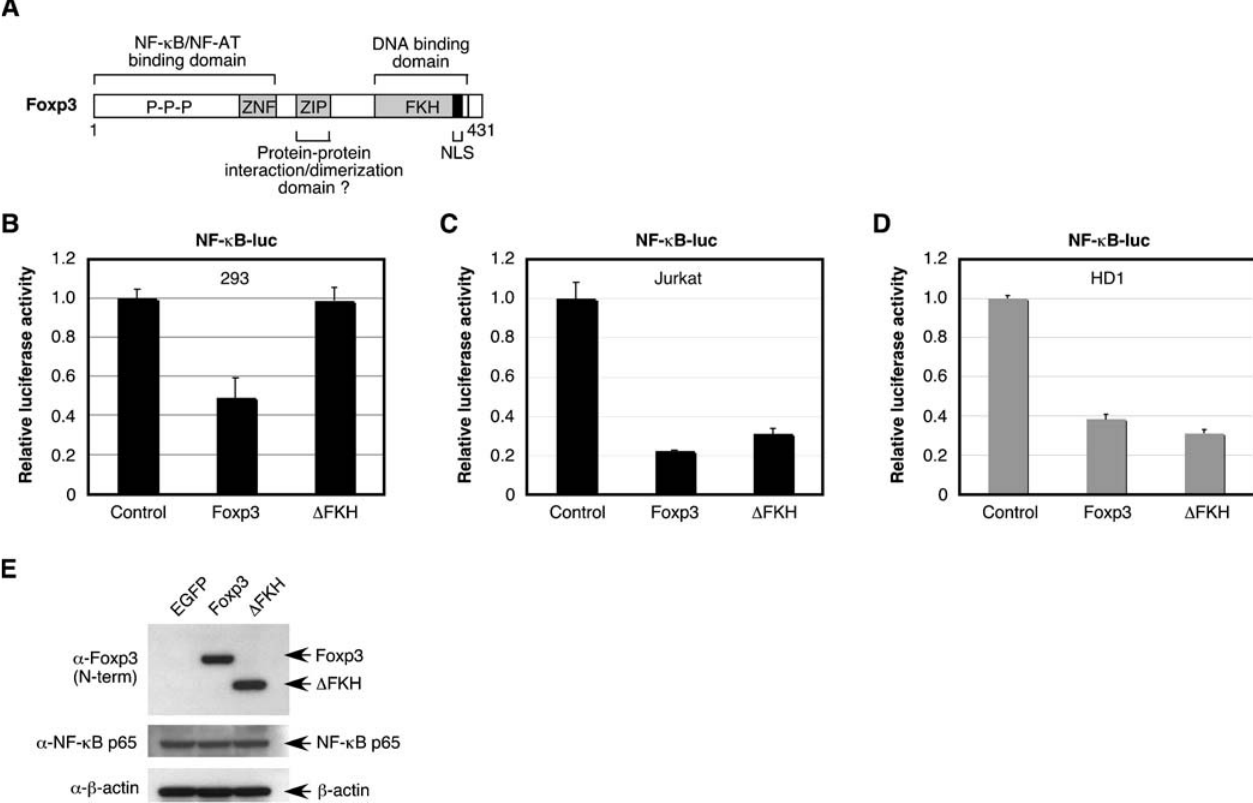
Figure 2. FKH Domain of Foxp3 Is Required to Inhibit NF- j B Activation in HEK 293T Cells but Not CD4 þ T Cells (A) Schematic representation of human Foxp3, including proline-rich (P-P-P), zinc finger (ZNF), leucine zipper (ZIP), and forkhead (FKH) domains. Mutations within the Foxp3 gene associated with IPEX have been previously described [4,14,43]. The FKH domain contains a nuclear localization signal (NLS), which is required for Foxp3 expression in the nucleus. (B and C) HEK 293T cells (5 3 10 5 ) (B) were seeded into six-well plates 1 d prior to transfection or Jurkat T cells (1 3 10 6 ) (C) were seeded into six-well plates on the day of transfection with an NF- j B luciferase reporter vector (200 ng) in the presence or absence of a Foxp3, D FKH, or control expression vector (1,000 ng) and internal reference plasmid (pGL4-TKhRluc2; 50 ng). Cells were harvested at 24 h posttransfection and analyzed for luciferase activity. Relative luciferase activity was normalized to the internal reference control. (D) CD4 þ T cells (2 3 10 6 ) from healthy donors were nucleofected with an NF- j B reporter plasmid (2,000 ng), together with either a Foxp3, D FKH, or control expression vector (2,000 ng), and an internal reference plasmid (1,000 ng). Cells were harvested 24 h posttransfection and analyzed for luciferase activity. Relative luciferase activity was normalized to the internal reference control. Results from one healthy donor are shown. (E) Foxp3, D FKH, and NF- j B p65 expression in whole-cell extracts (20 l g) derived from HEK 293T cells transfected with a control expression vector (EGFP), Foxp3, or D FKH expression vectors were analyzed by Western blot analysis. b -actin expression was analyzed as a loading